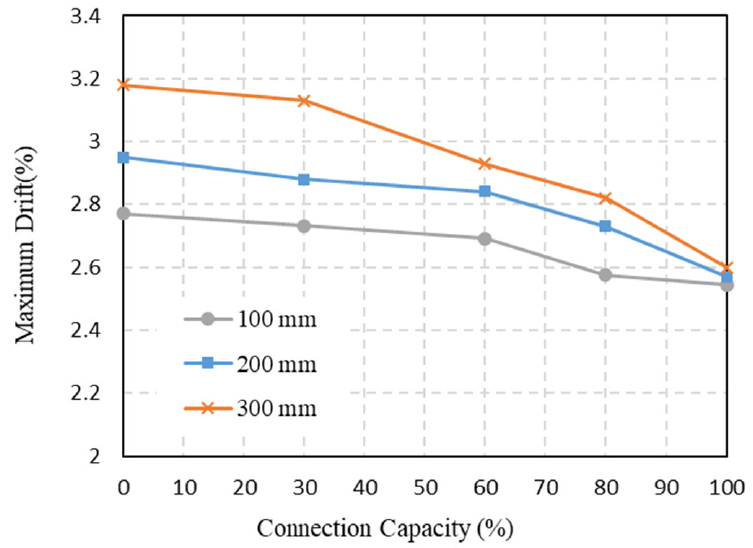
Figure 19. Maximum story drifts of 5-story frame subjected to 5 earthquake records.